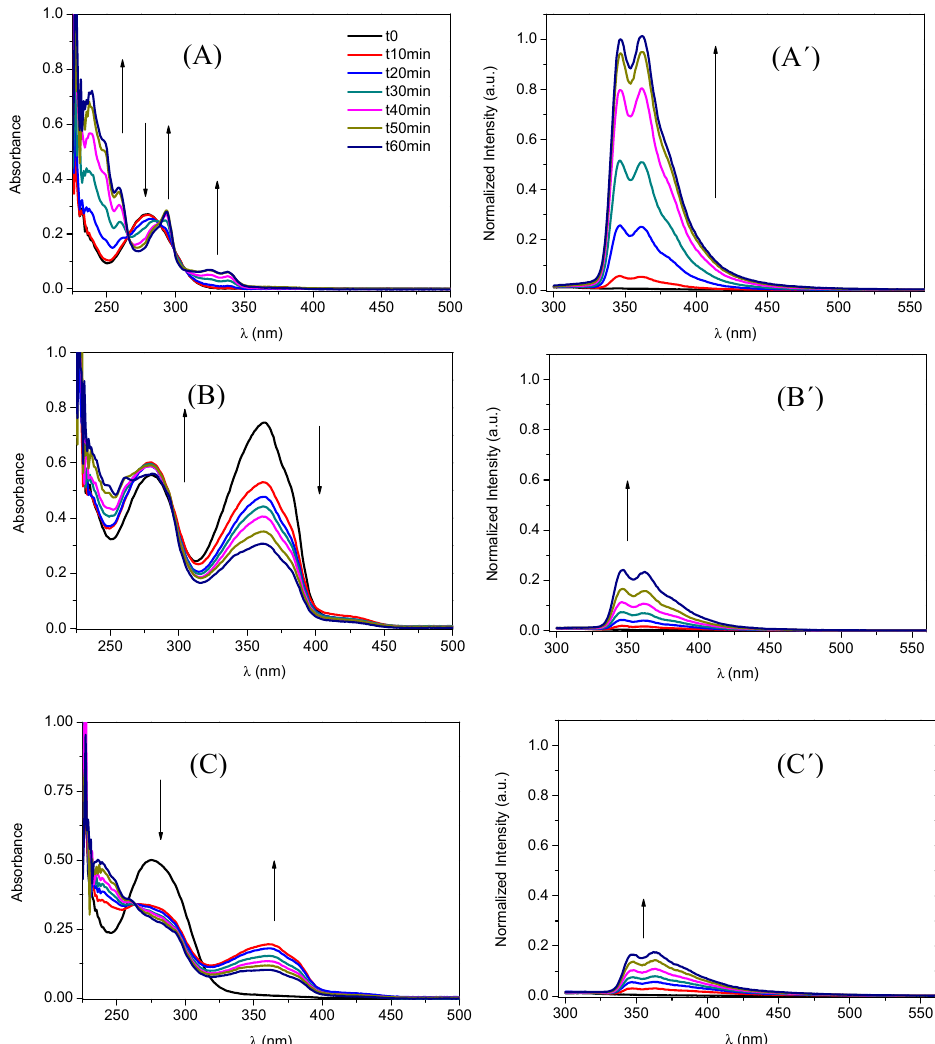
Figure 5. UV-Vis spectra (left ( A – C )) and fluorescence emission spectra (right, ( A’ – C’ )) of DCF alone ( A , A’ ), the equimolar DCF+AB mixture ( B , B’ ), and the AB-DCF dyad ( C , C’ ) obtained during the SSL irradiation of aerated diethylene glycol solutions (1.7 × 10 − 5 M).